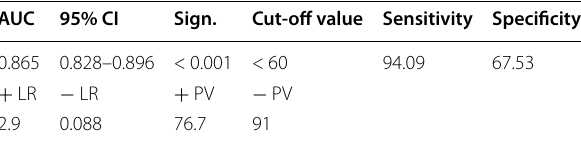
Table 6 Receiver operator characteristic curve of vitamin D predict mortality AUC 95% CI